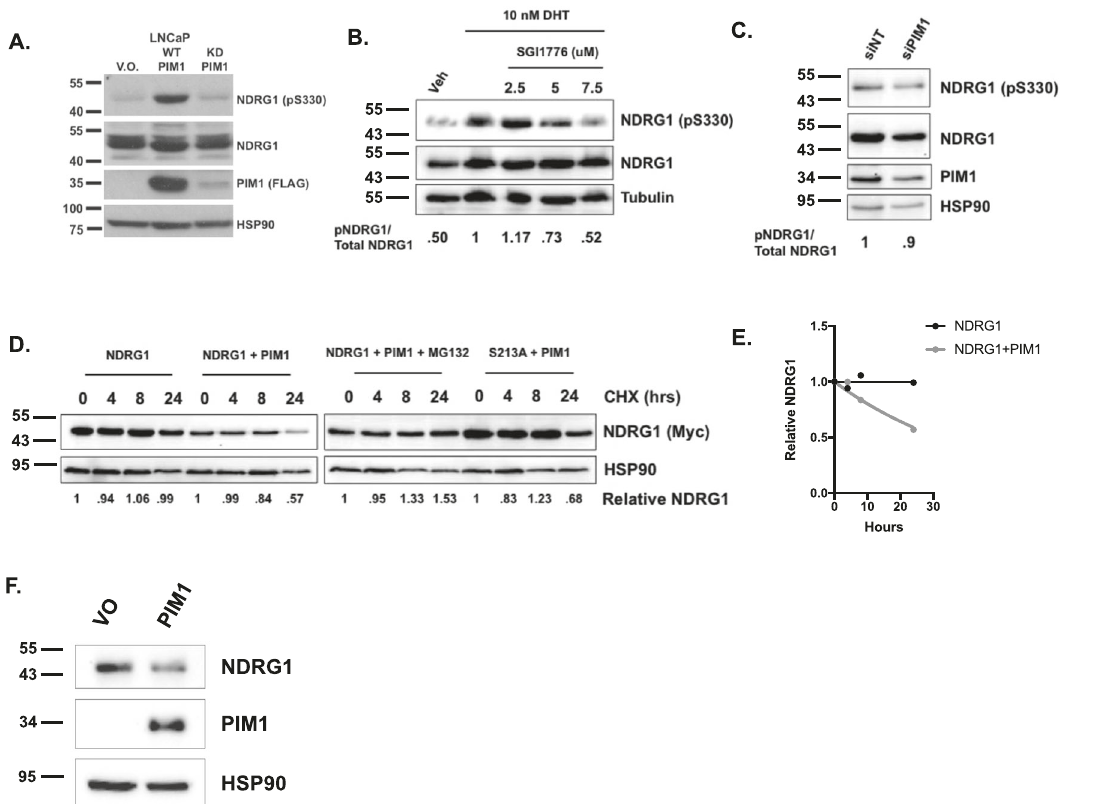
Fig. 5 PIM1-mediated NDRG1 pS330 is androgen-dependent, and reduces its stability. A LNCaP cells stably expressing vector only (LNCaP V.O.), WT PIM1 (LNCaP-WT PIM1), or kinase-dead PIM1 (LNCaP KD PIM1) were steroid-starved for 48 h, and Western blot was performed for NDRG1 pS330, total NDRG1, PIM1 (FLAG), and HSP90 (loading control). B LNCaP and VCaP cells were steroid-starved for 48 h, treated with 10 nM DHT, along with indicated amounts of PIM1 kinase inhibitor SGI-1776 for 24 h, and western blot was performed for NDRG1 pS330, total NDRG1, and HSP90. The ratio of NDRG1 pS330/total NDRG1 was quanti fi ed using ImageJ software. C Under the same conditions as Fig. 2B, PIM1 was knocked down using siRNA and western blot was performed for NDRG1 pS330, total NDRG1, PIM1, and HSP90. Ratios were quanti fi ed using ImageJ software. D Effect of PIM1-dependent phosphorylation on NDRG1 stability. NDRG1 WT and S330A were expressed in 293 cells, with and without PIM1. Cells were treated with cycloheximide for the indicated times, lysates prepared and blotted for NDRG1 and HSP90. Additionally, WT NDRG1 + PIM1 was treated with MG-132. E Extrapolated half- lives of NDRG1 under the various conditions are shown. F PIM1 overexpression in LNCaP cells results in loss of endogenous NDRG1.